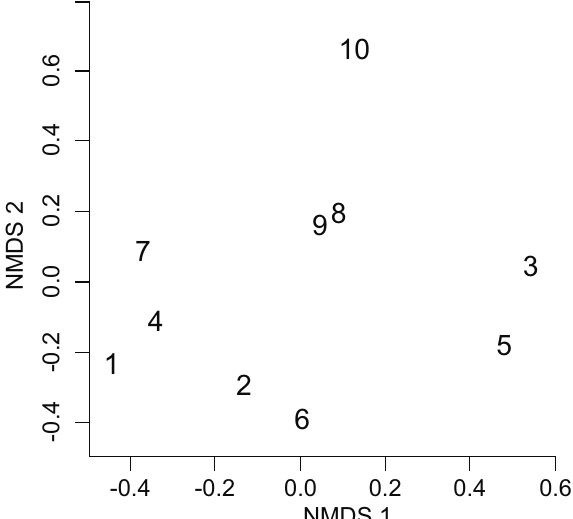
Figure 2. Non-Metric Multidimensional Scaling ordination of the 10 stream sites. Number refers to stream sites shown in figure 1. Stress = 0.07.